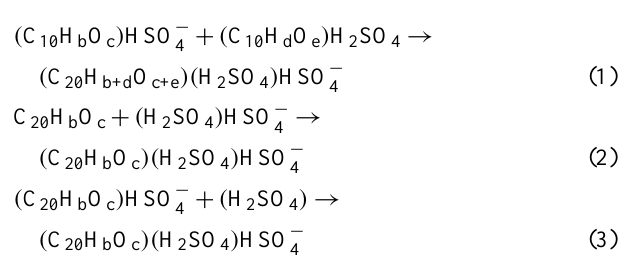
Figure 5. Stacked peak area for observed clusters containing C 20 H b O c according to core ion(s) of positive (a and d), negative (b and e), and neutral (c and f) clusters obtained from α -pinene ozonolysis with OH scavenger (a–c) and α -pinene oxidation by OH only (d–f).